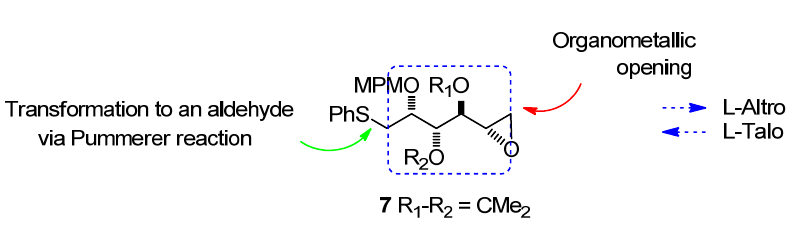
Figure 4. Targeted structure 7